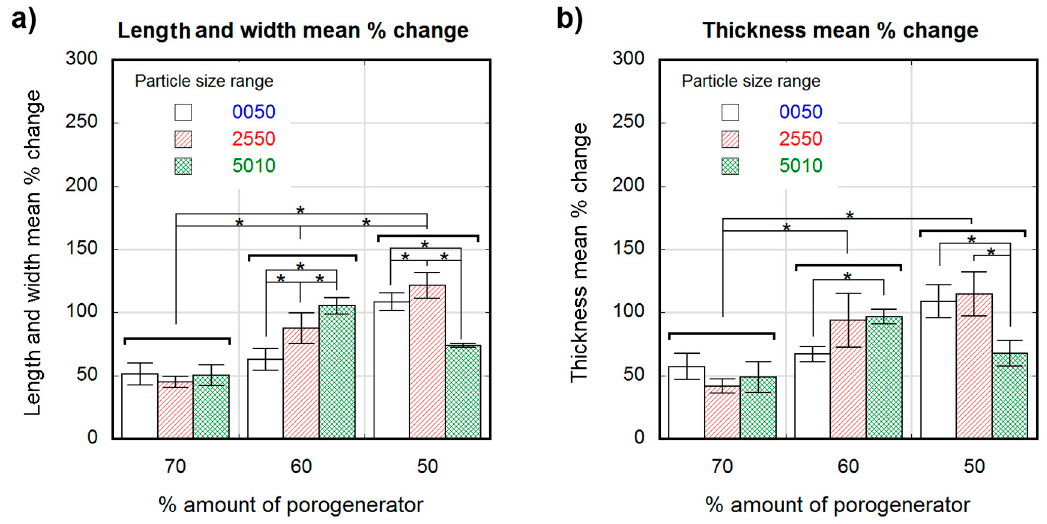
Figure 3. Dimensional variation in percental values for wet scaffolds obtained from different particle sizes (white 0–50-µm, stripe pattern 25–50-µm, cross pattern 50–100-µm) and proportions as a function of the theoretical percental amount of porogenerator: Scaffold length and width mean % change ( a ); scaffold thickness mean % change ( b ). Significance level according to the Student t -test * p < 0.05.